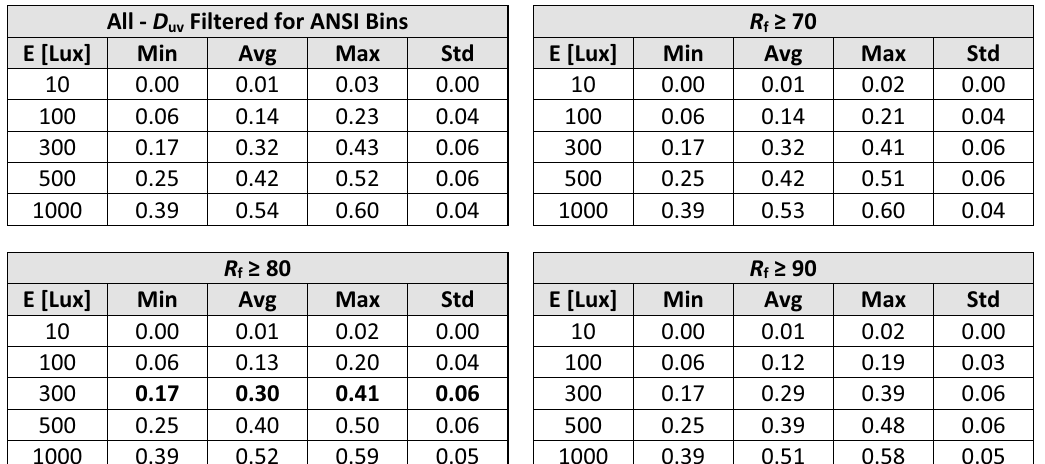
Table 2. Statistical summary of Circadian Stimulus for SPDs with various fidelity ( R f ) filtering. This table can be used as a quick reference to gauge the magnitude of CS for an SPD based on its specified corneal illuminance (E v ) and approximate R f . For example, a light source with an R f of 81 at 300 lx is likely to have a CS between 0.17 and 0.41 (not considering CCT); See bolded values in